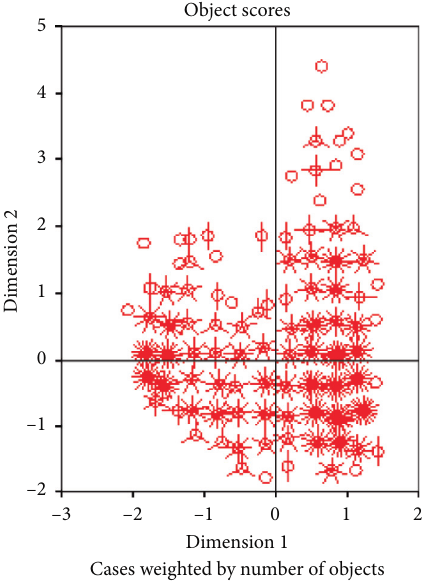
Figure 3: Object scoring diagram of multivariate correspondence